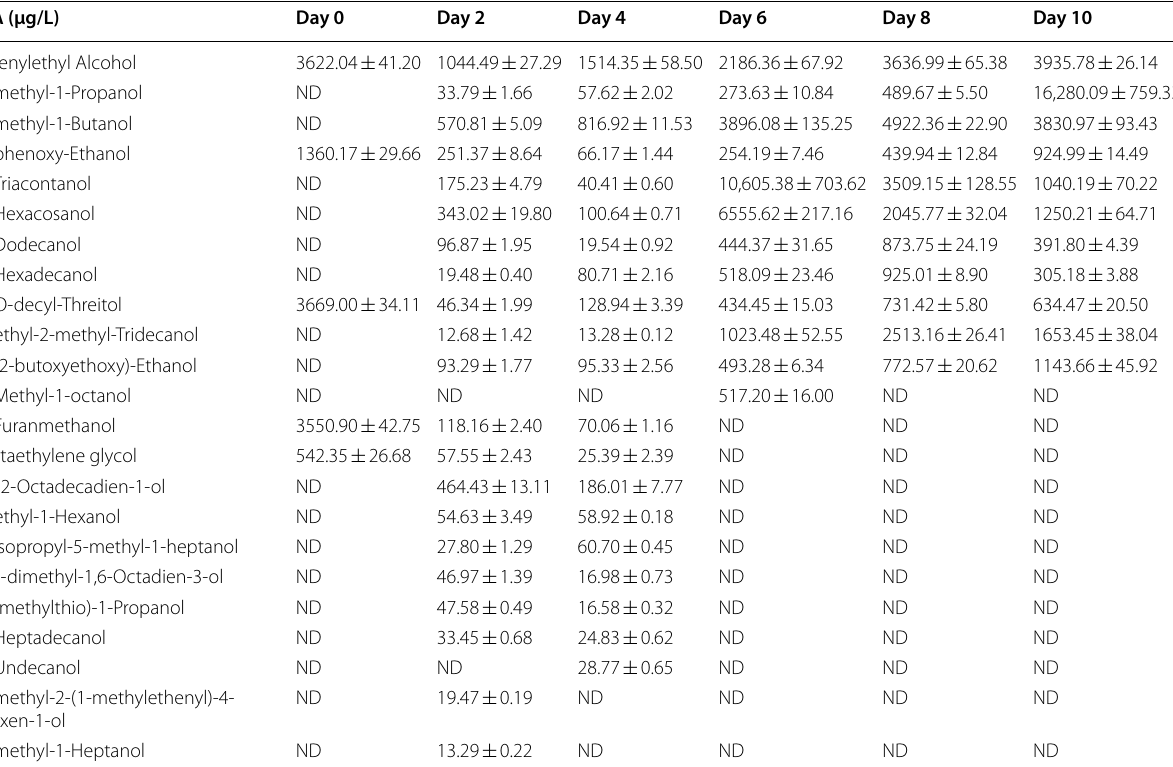
Table 1 The changes of HA during the fermentation of northern Huangjiu